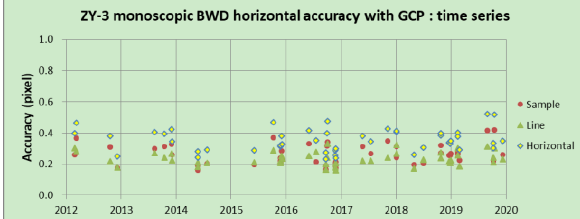
Figure 9. ZY-3 monoscopic BWD horizontal accuracy